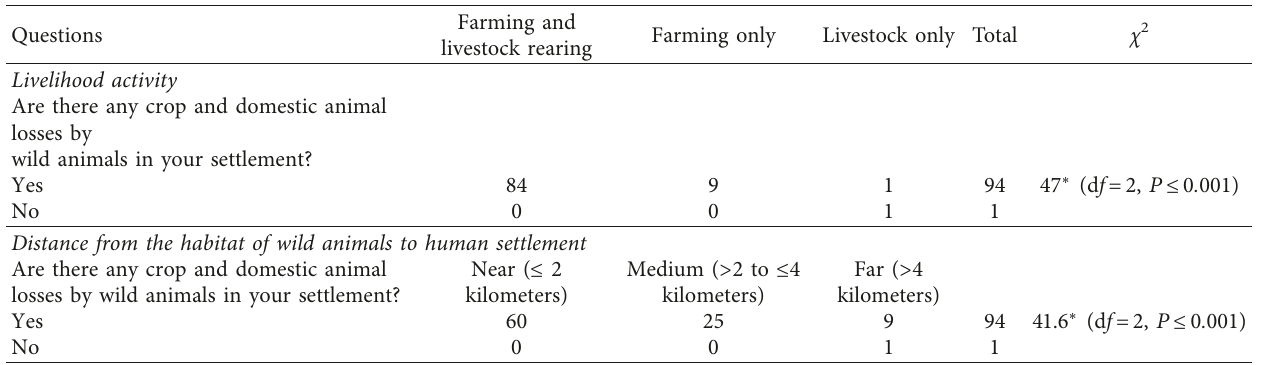
Table 2: The crop and domestic animal loss by wild animals based on the livelihood activity and distance from the habitat of wild animals.